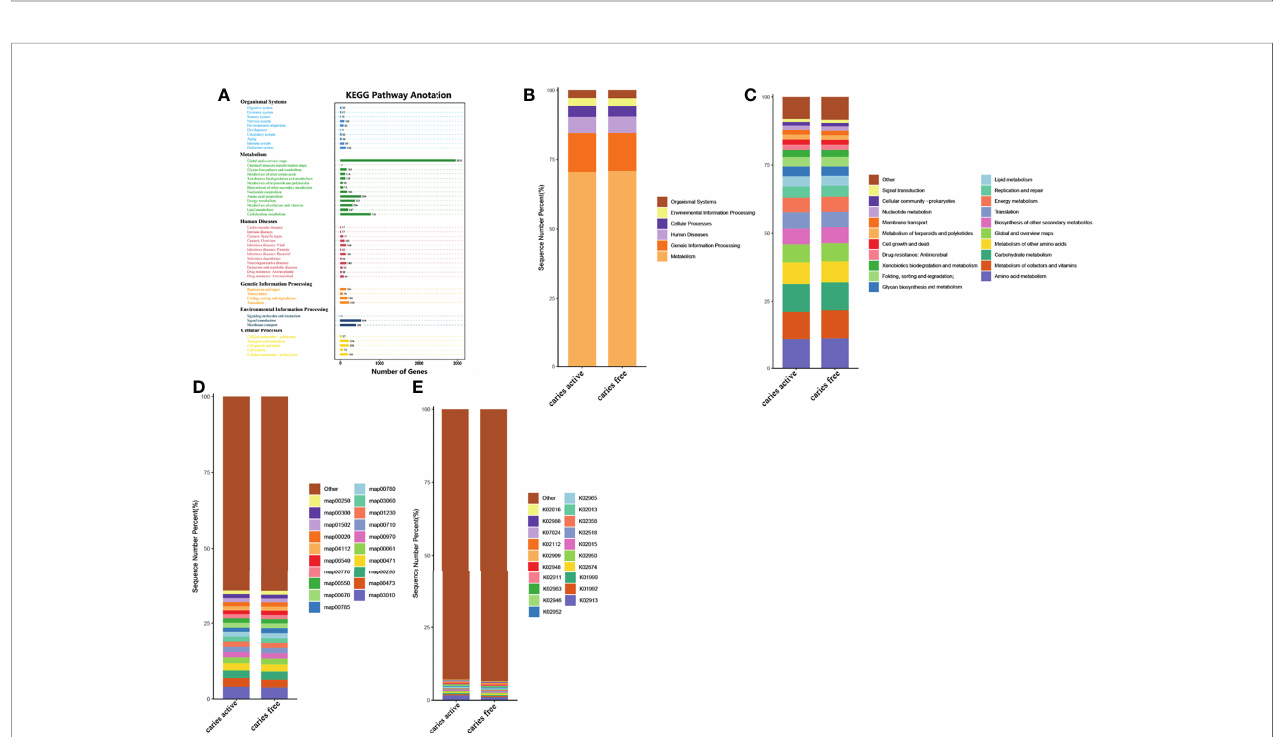
FIGURE 4 | Comparing the functional characteristics of the microbiome caries active group and caries free controls. (A) The number of genes annotated in the Kyoto Encylopedia of Genes from the 40 samples. (B) The comparison of functional KEGG between the two groups at the level 1 pathway, (C) level 2 pathway, (D) level 3 pathway, and (E) ortholog level. The horizontal axis represents the relative abundance of annotated genes. The histograms show the top 20 annotated genes predicted in the metabolic